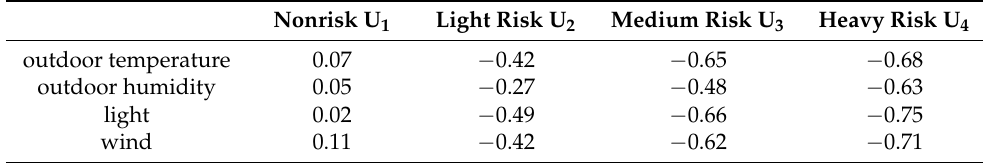
Table 7. Correlation degree of outdoor meteorological